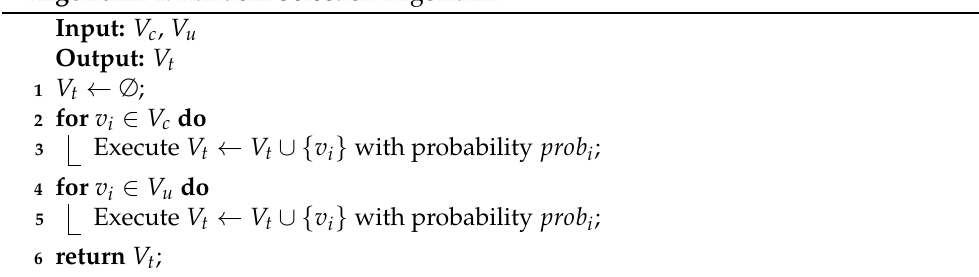
Algorithm 4: Random Selection